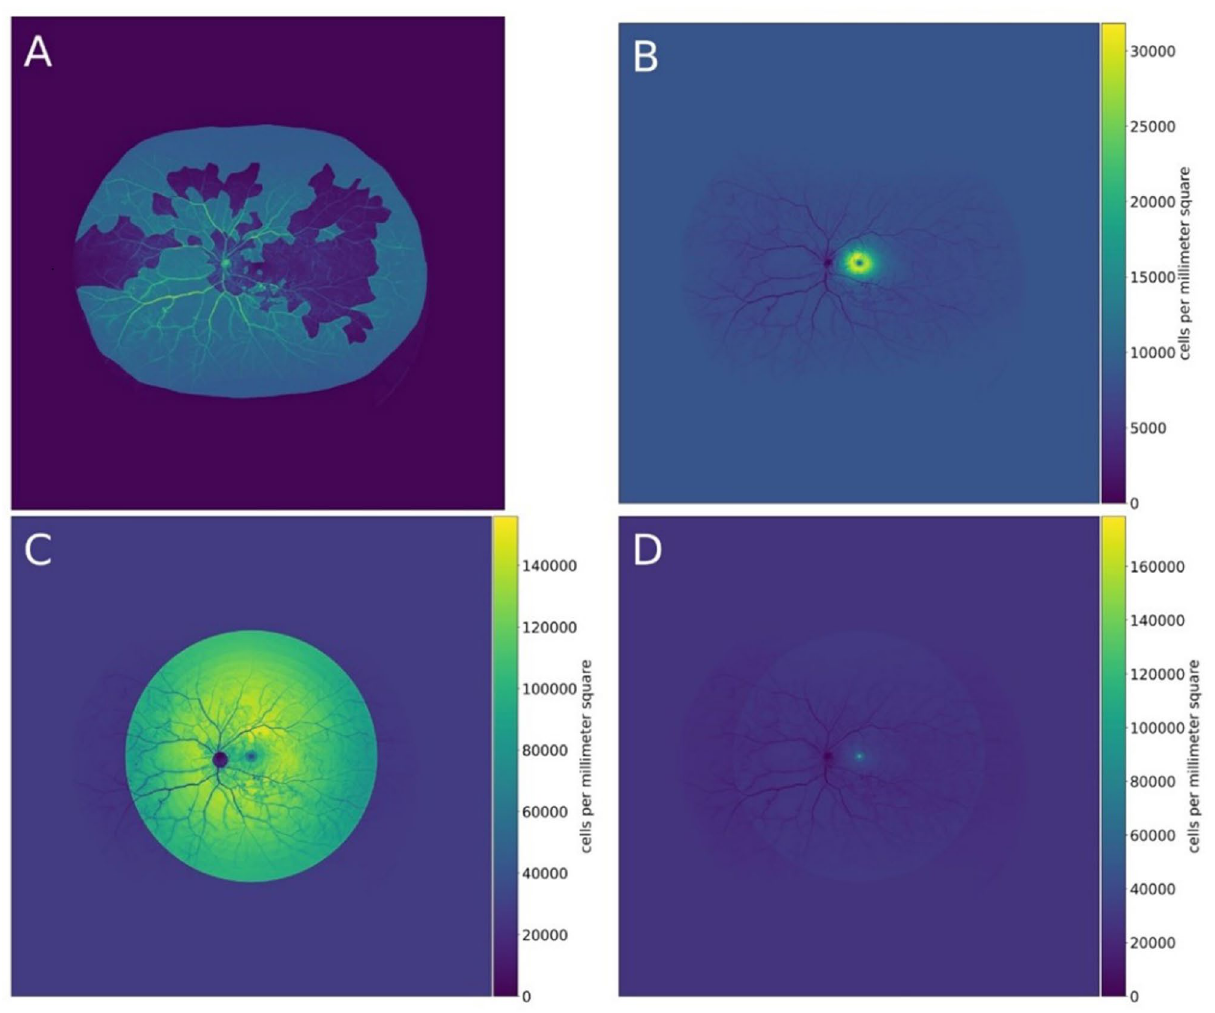
Figure 3. Metabolic quantification of ultra-widefield fluorescein angiography (UWF FA) image. ( A ) Shows an UWF FA image with annotation of the nonperfusion region with leakage overlaid in green. ( B ) Shows the ganglion cell density map overlayed on the same UWF FA image with a density scale in cells per square millimeter. The estimated number of affected ganglion cells of 1 pixel is calculated by multiplying the size of that pixel on the retina in square millimeters with the ganglion cell density of the corresponding pixel in ( B ) in cells per square millimeters. The total number of affected ganglion cells in the annotated area (green) in ( A ) is the sum of these multiplications for all pixel parts of the annotated area (green) in ( A ). ( C ) shows the rod photoreceptor density map and ( D ) shows the cone photoreceptor density map overlayed on the same UWF FA